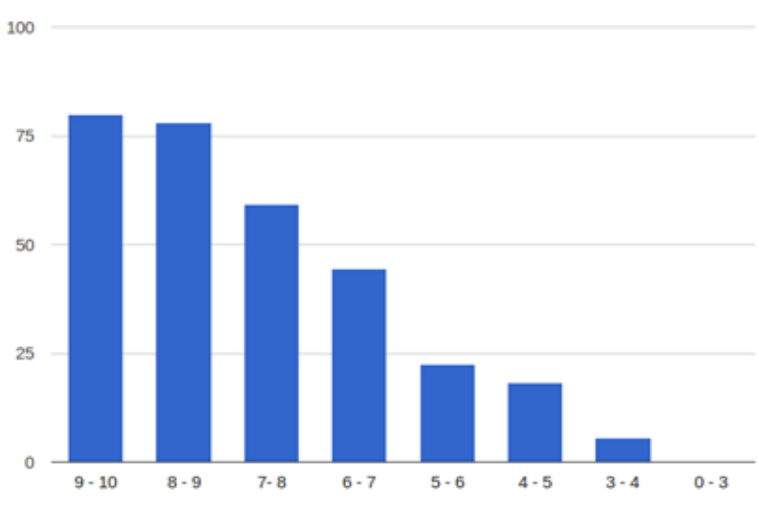
Figure 5. The percentage of active students decreases linearly to their average